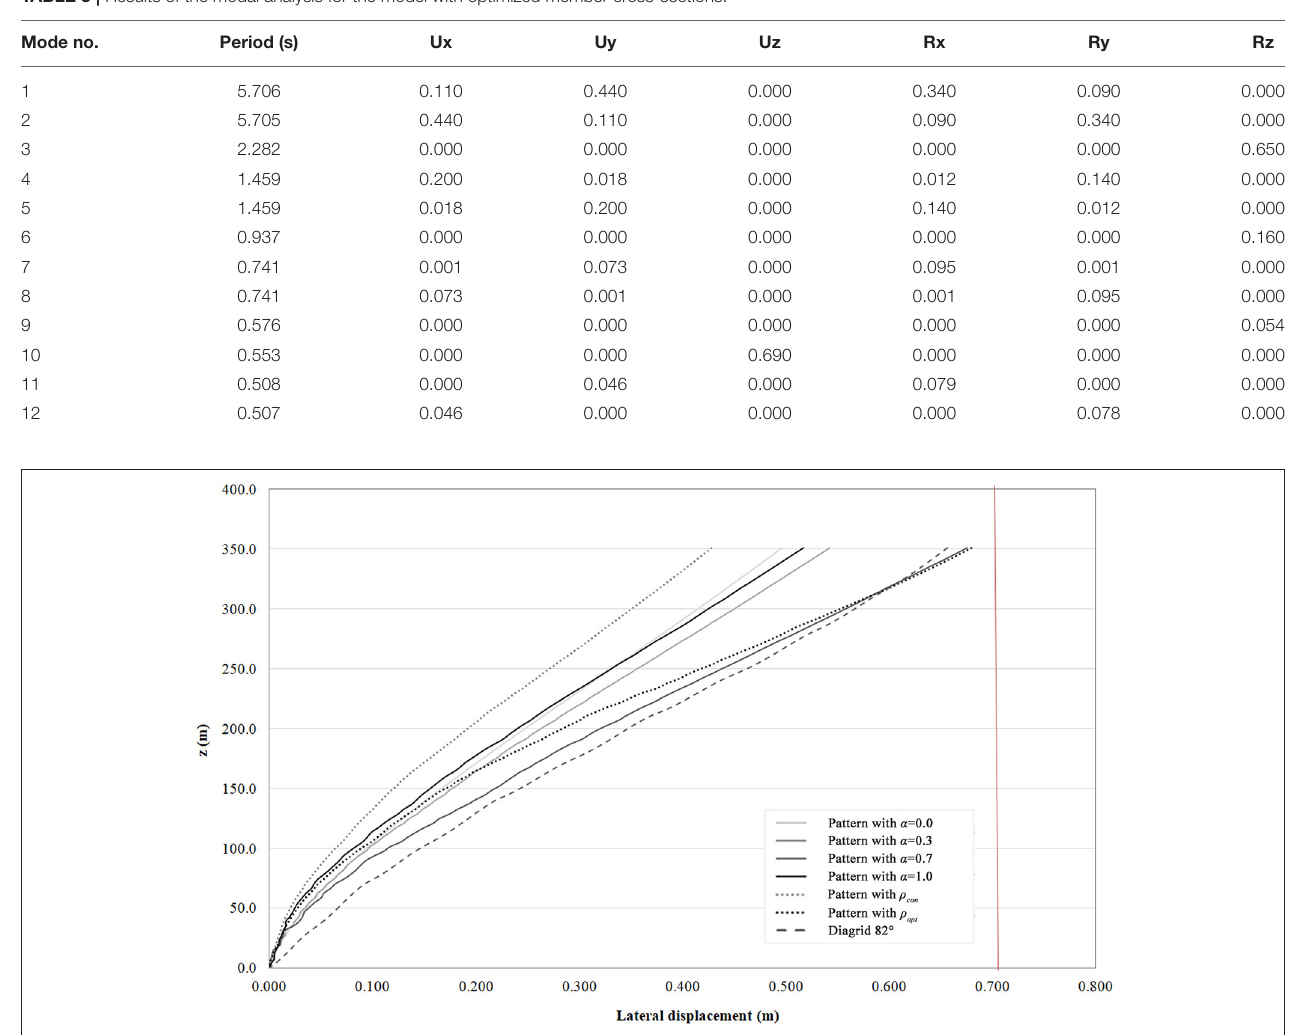
FIGURE 12 | Comparison of lateral displacements under wind forces of the analyzed